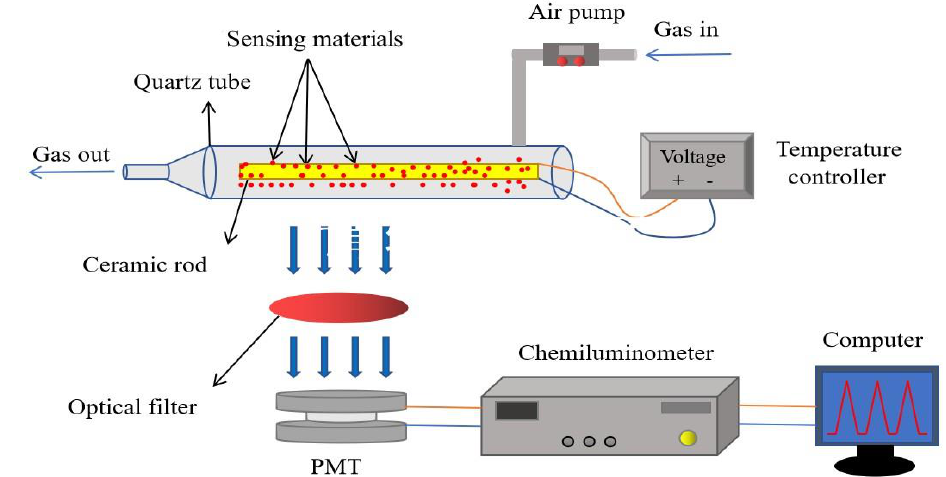
Figure 1. Schematic view of the BPCL - 1 sensor